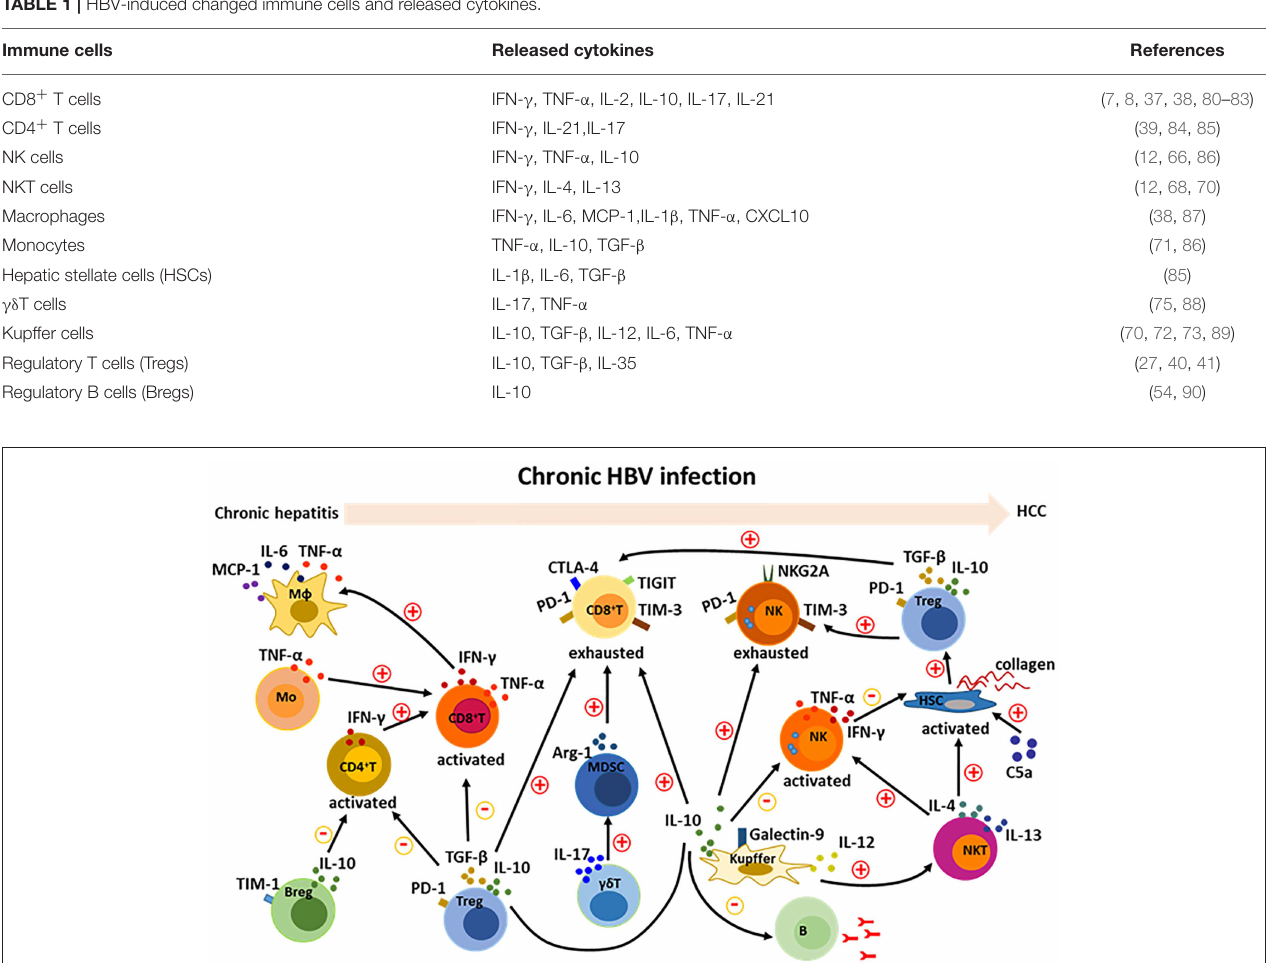
FIGURE 3 | Cross-talk among immune cells in the development of HBV-related HCC. During chronic HBV infection, there are complicate interactions among immune cells. Activation of CD8 + T cells is enhanced by CD4 + T and monocytes; and then activated CD8 + T cells recruit and activate macrophages. Activation of NKT cells can be promoted by Kupffer cells, and further activate NK cells and HSCs. On the other hand, suppressive Tregs, Kupffer cells and Bregs inhibit the activation of CD4 + T, CD8 + T, and NK cells. Furthermore, Tregs, Kupffer cells, and MDSCs contribute to the formation of exhausted CD8 + T and NK cells. A variety of cytokines including IFN- γ , TNF- α , IL-6, MCP-1, IL-4, IL-13, IL-12, IL-17, IL-10, and TGF- β are involved in the cross-talk between immune cells. Additionally, complement protein such as C5a positive regulate the activation of